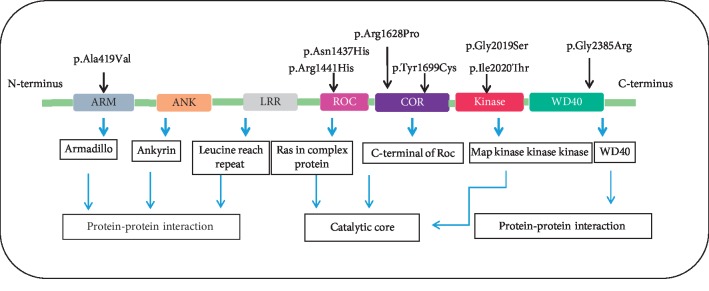
LRRK2 protein: functional domain and the localization of 8 variants. ANK-ankyrin repeat; ARM-armadillo; LRR-leucine-rich repeat; ROC-Ras of complex proteins: GTPase; COR-C-terminal of ROC; WD40-WD-40 domain. Pathogenic mutations are highlighted in blue, and East Asian disease-associated variants are highlighted in red.